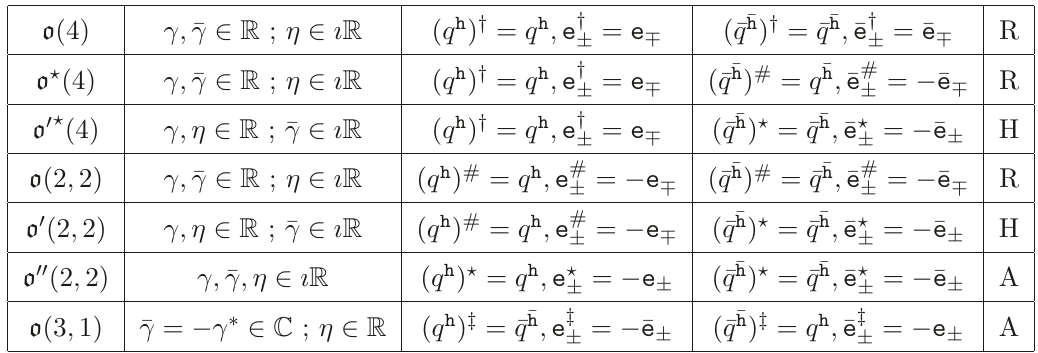
Table 4 . Real quantizations of r III ( γ, ¯ γ, η ) = γ E + ∧ E − + ¯ γ ¯ E + ∧ ¯ E − + η H ∧ ¯ H